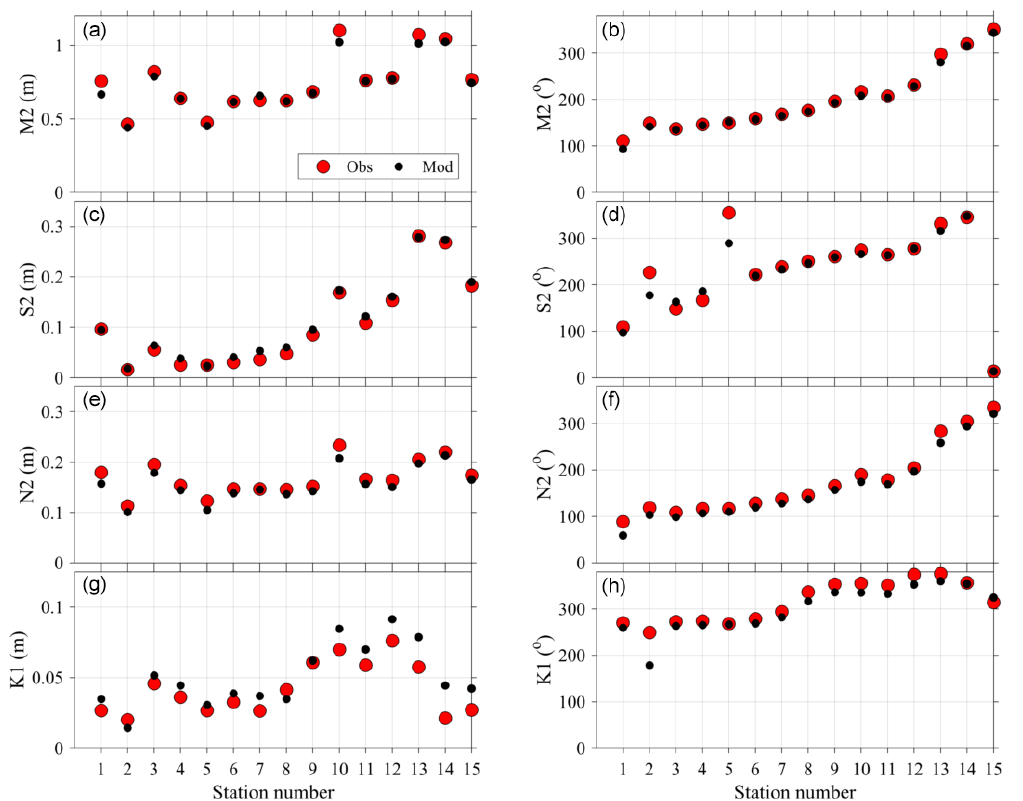
Figure 11. Harmonic tidal amplitude (left panels; a, c, e, g ) and phase (right panels; b, d, f, h ) estimated from observed sea level (red) and modelled (black) time series for 15 stations around New Zealand (Table 2). Station numbers ( 1 – 15 ) are indicated to follow anticlockwise Kelvin wave propagation from the southeast station (Port Chalmers, 1 ) to the southwest (Puysegur, 15 ). Amplitude and phase are shown for the M 2 (a, b) , S 2 (c, d) , N 2 (e, f) and K 1 (g, h) tidal constituents.